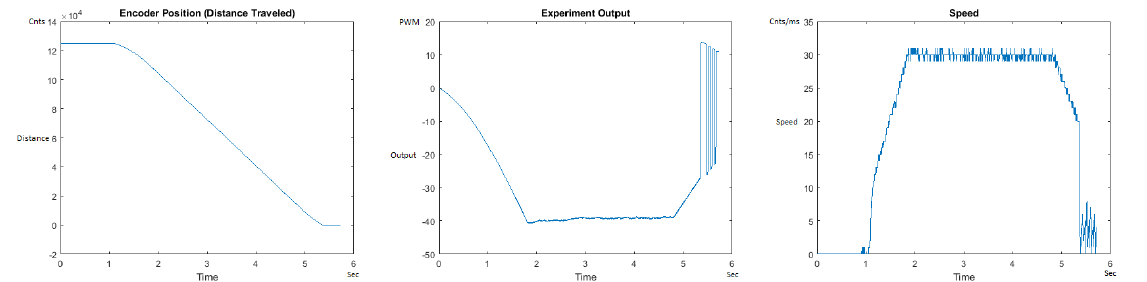
Figure 22. Encoder position, output and speed plots for PID++ UP operation— Vmax 120 cnts/ms, Adesired 0.055 cnts/ms 2 — 1 Kg.